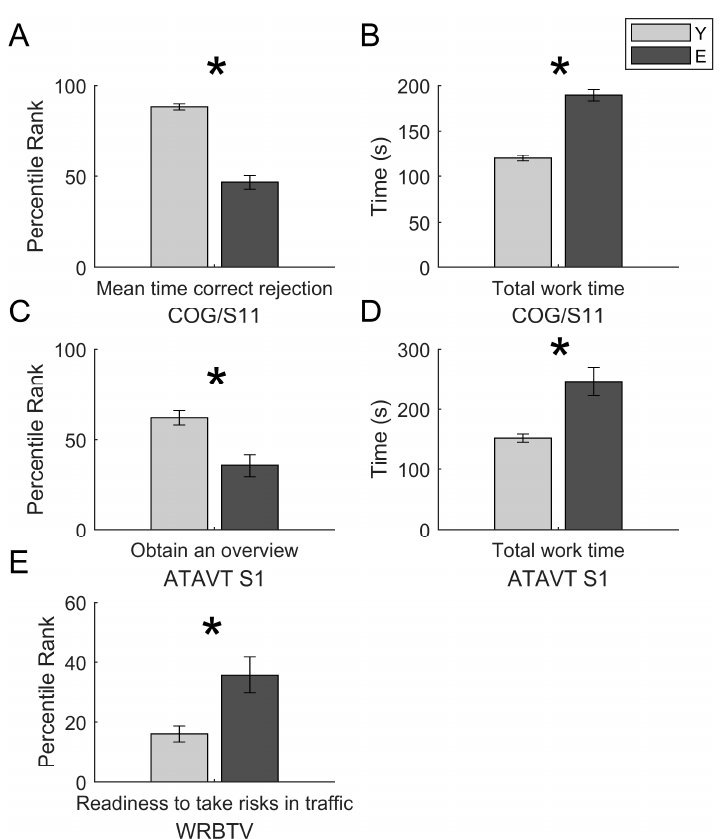
Figure 3. Results on measures of driving-related abilities. Means and standard errors of measures of selective attention as measured by COG S/11 (mean time correct rejections ( A ); total working time ( B )), of tachistoscopic perception as measured by ATAVT S1 (performance ( C ); total working time ( D )), and risk assumption (WRB-TV ( E )). For all graphs, the asterisks denote significant differences.